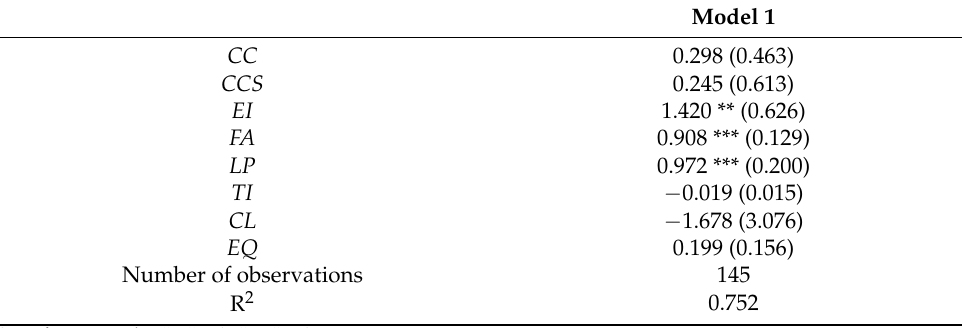
Table 3. Regression results of Model